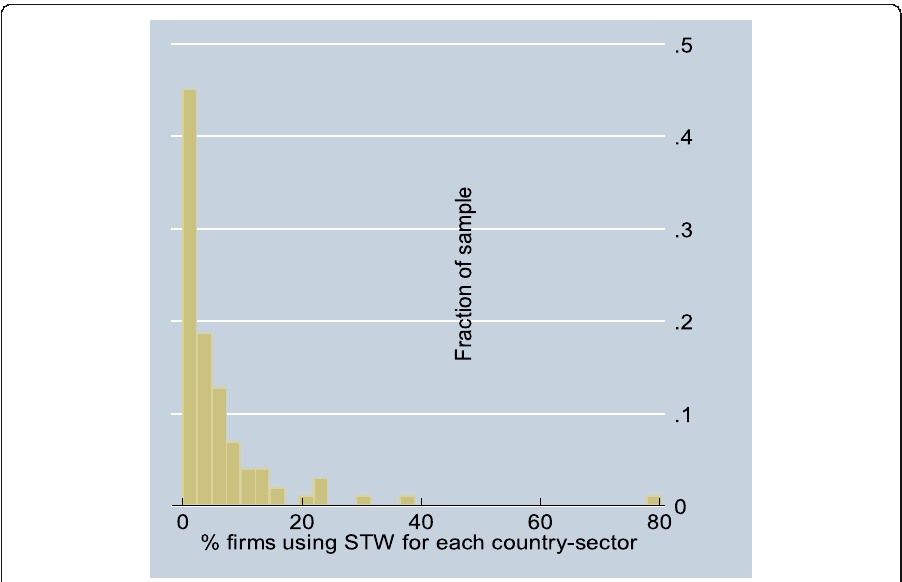
Fig. 5 Distribution of the proportion of firms at the country-sector level using